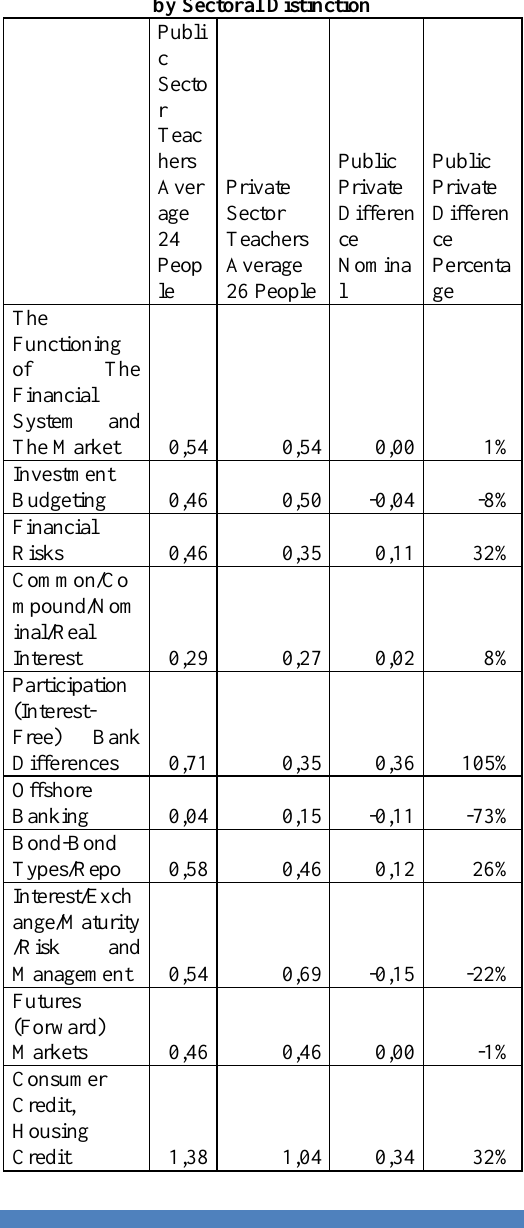
Table 6. Average Knowledge Level Felt by